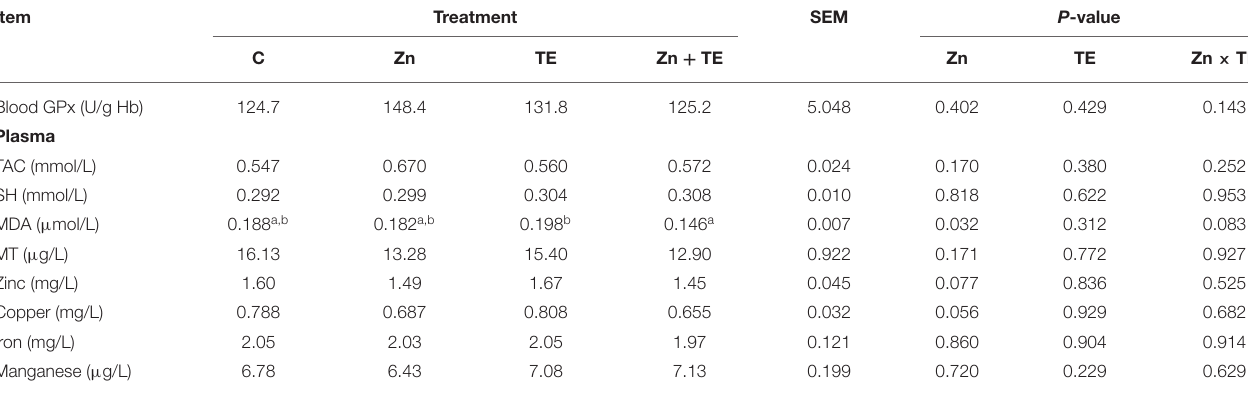
TABLE 3 | The effect of organic zinc and/or thyme extract administration on the antioxidant indices and microelements concentration in plasma or blood of rabbits.